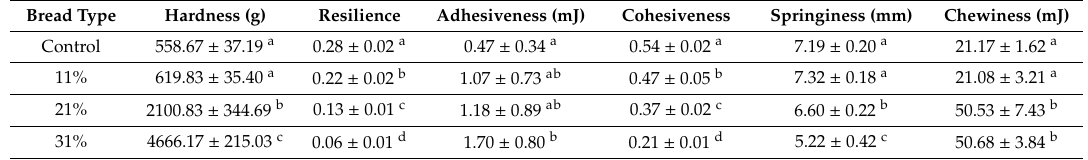
Table 4. Texture properties of control bread, and 11%, 21% and 31% of BBH fortified breads. Bread Type Hardness (g) Resilience Adhesiveness (mJ) Cohesiveness Springiness (mm) Chewiness